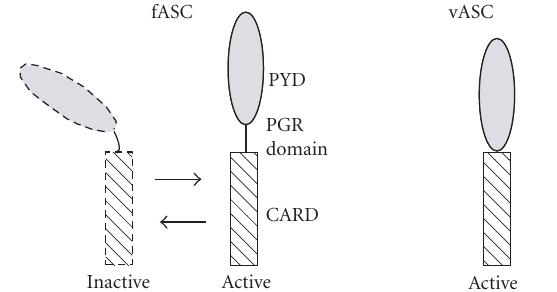
Figure 6: Hypothesized structure of fASC and vASC showing the PGR domain